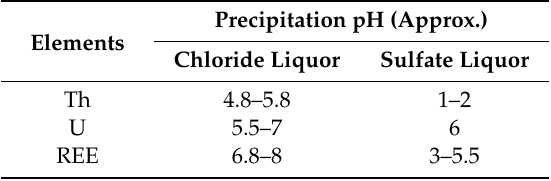
Table 3. The pH ranges for precipitation of thorium, uranium and the REE in di ff erent liquors.